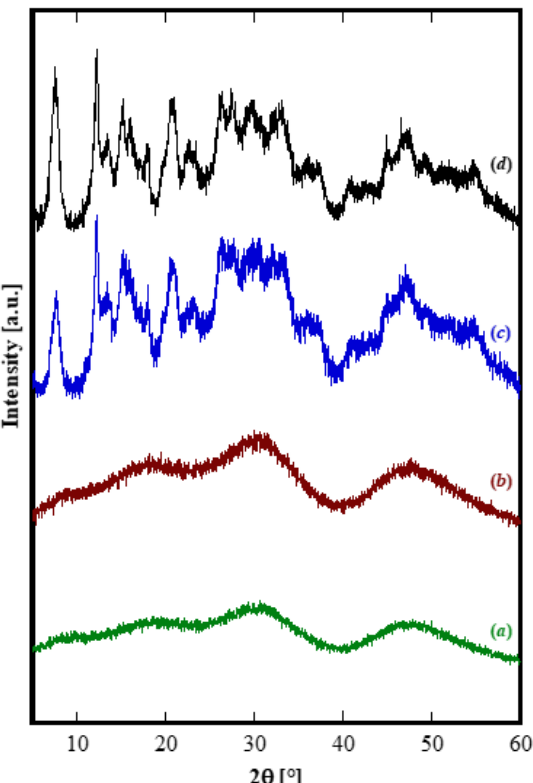
Figure 2. Diffraction patterns of Yb-based products for several durations: ( a ) 8 h with R = 2.5, ( b ) 48 h with R = 2.5, ( c ) 48 h with R = 10, and ( d ) 210 h with R = 10.